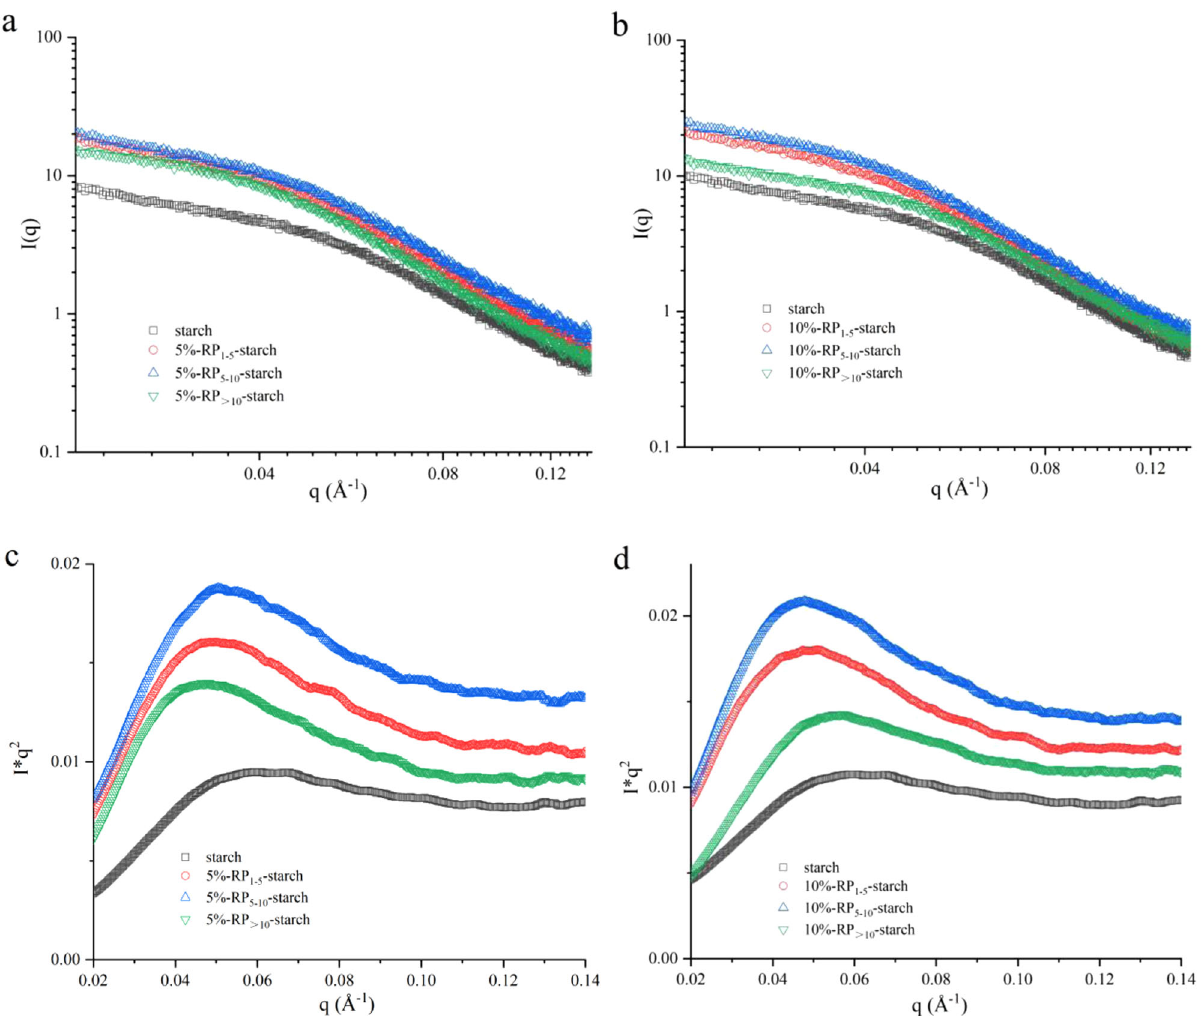
Fig. 4 SAXS curves and Kratky plots of cooked starch and RP-starch complexes. a SAXS curves of 5% RP-starch complexes. b SAXS curves of 10% RP-starch complexes. c Kratky plots of 5% RP-starch complexes. d Kratky plots of 10% RP-starch